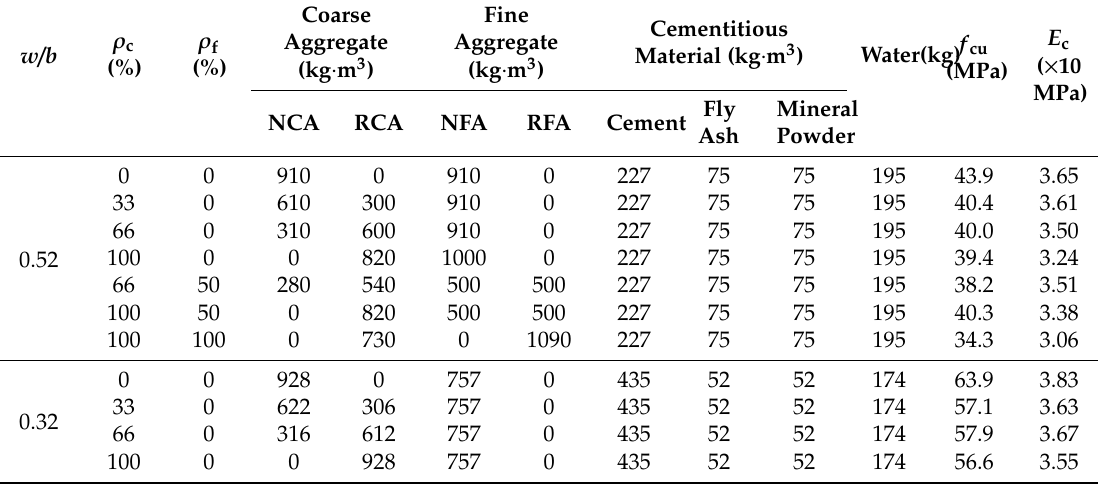
Table 4. Mix proportion of the